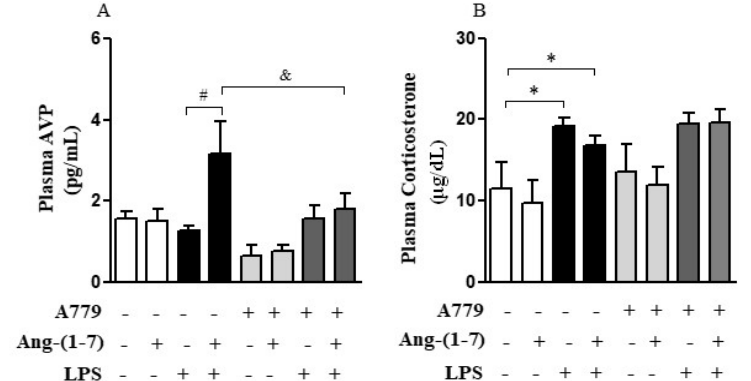
Figure 4. Central administration of Ang-(1-7) restored plasma AVP levels in endotoxemic rats via Mas receptor. Effect of central Ang-(1-7) on the AVP ( A ) and corticosterone ( B ) plasma levels in rats 6 h after LPS administration (1.5 mg/Kg, i.v.). A779 (3 nmol in 2 µL, i.c.v.), a selective antagonist for Mas receptor, was injected 30 min before central Ang-(1-7) administration (0.3 nmol in 2 µL, i.c.v.). Data are expressed as the mean ± SEM, n = 7–10. ANOVA, followed by Bonferroni post-hoc test. * p < 0.05 versus Saline (i.c.v.) + Saline (i.v.) group, # p < 0.05 versus Saline (i.c.v) + LPS (i.v.) group, and & p < 0.05 versus Ang-(1-7) (i.c.v) + LPS (i.v.) group.